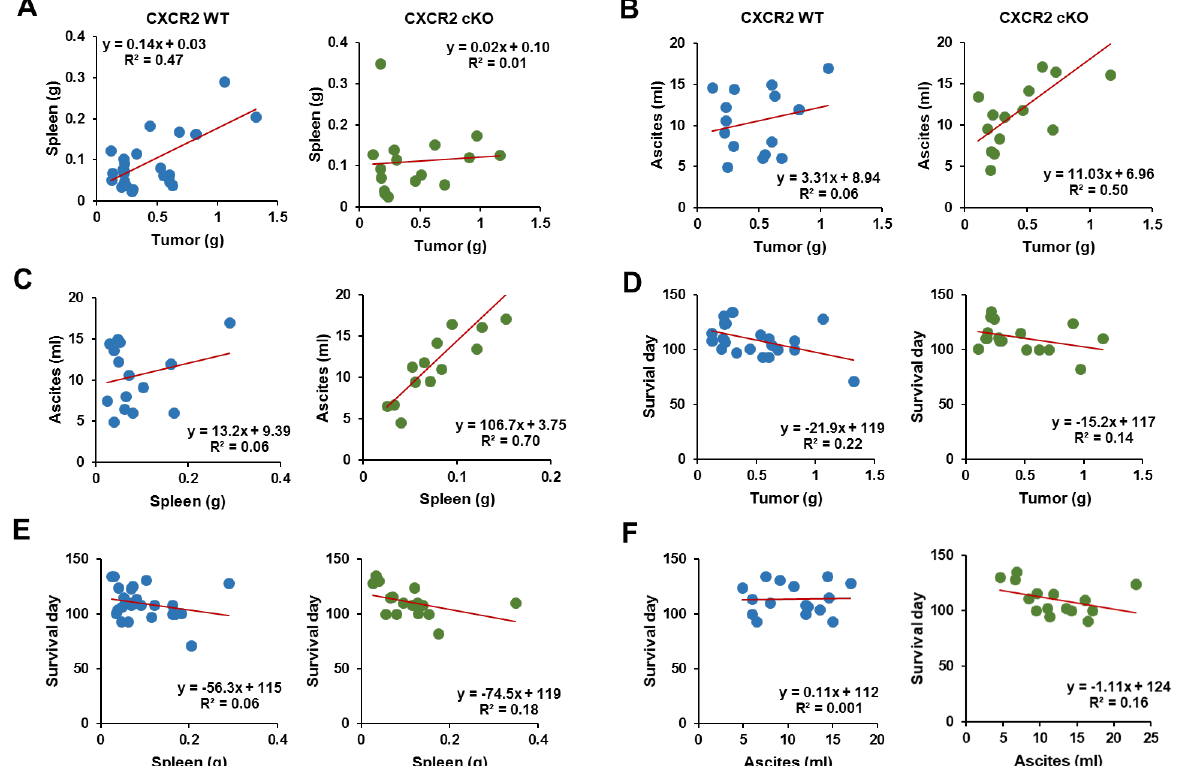
Figure 7. Correlations in tumor parameters between CXCR2 WT and cKO mice. (A) Correlation of tumor and spleen weights from CXCR2 WT and cKO mice. (B) Correlation of tumor weights and ascites volumes in CXCR2 WT and cKO mice. (C) Correlation of spleen weights and ascites volumes in CXCR2 WT and cKO mice. (D) Correlation of tumor weights and survival days in CXCR2 WT and cKO mice. (E) Correlation of spleen weights and survival days in CXCR2 WT and cKO mice. (F) Correlation of ascites volumes and survival days in CXCR2 WT and cKO mice.